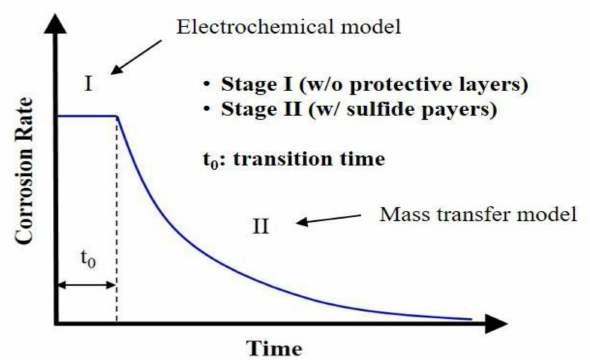
Figure 3. A schematic diagram of the two-stage model for uniform corrosion as a function of time (after